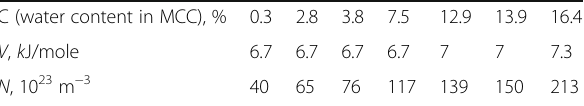
Table 4 Concentration of relaxation oscillators N and energies difference V for the samples of MCC with different water content